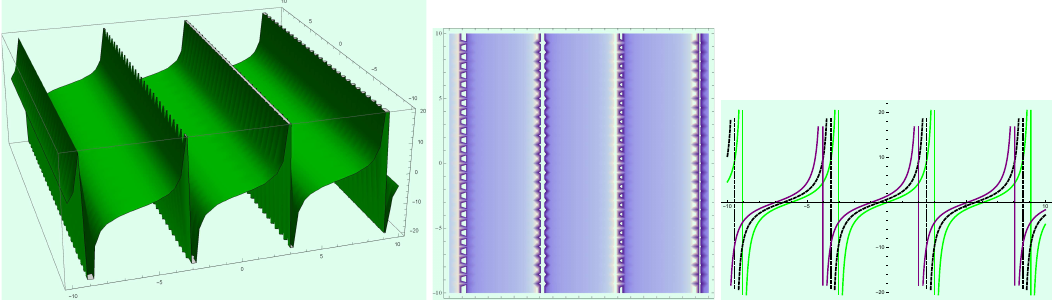
Figure 13. Profile of traveling wave solution (28) when t = 1 and x = 4.